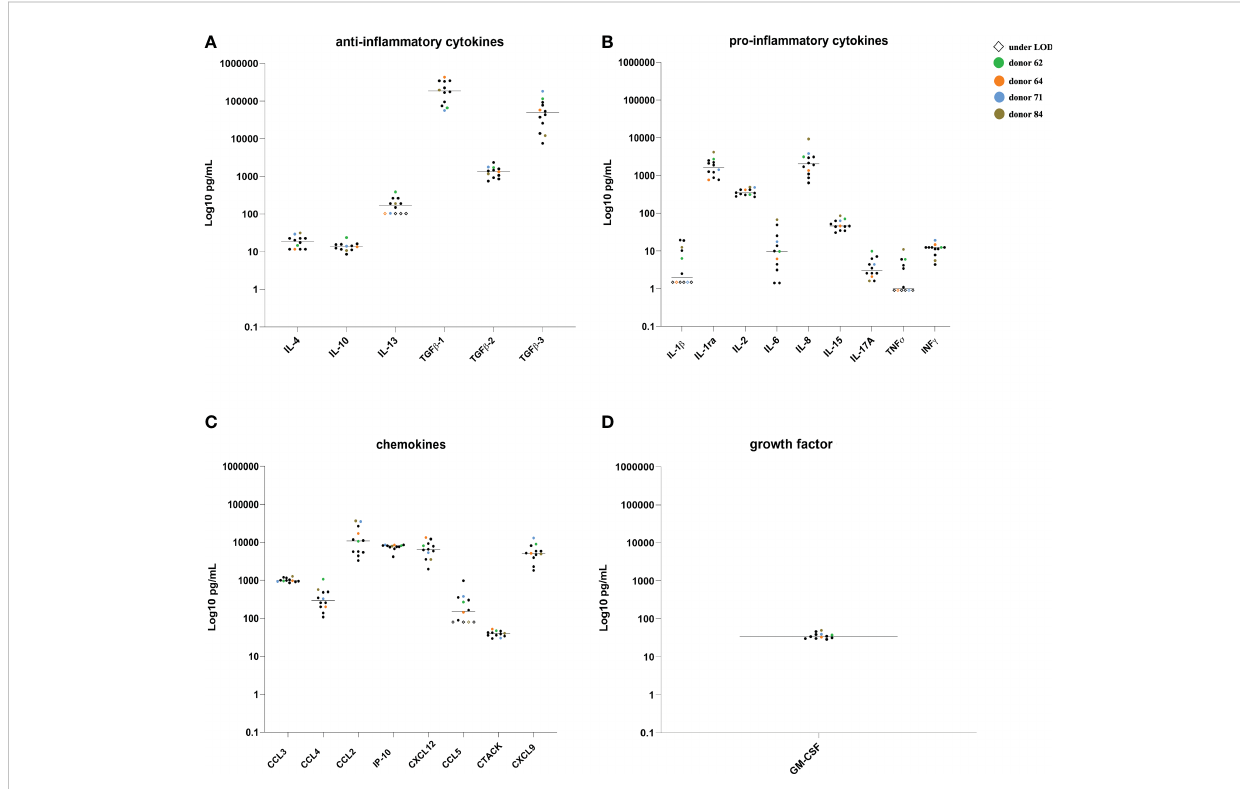
FIGURE 2 Cytokines, chemokines and GM-CSF quanti fi cation in the HSP from 12 fertile donors. Concentrations (pg/mL) of ant-in fl ammatory cytokines (A) , pro-in fl ammatory cytokines (B) , chemokines (C) and GM-CSF (D) in single samples from HIV negative fertile subjects. Colored symbols identify HSP of four donors subsequently used for colonic ex vivo cultures. LOD, limit of